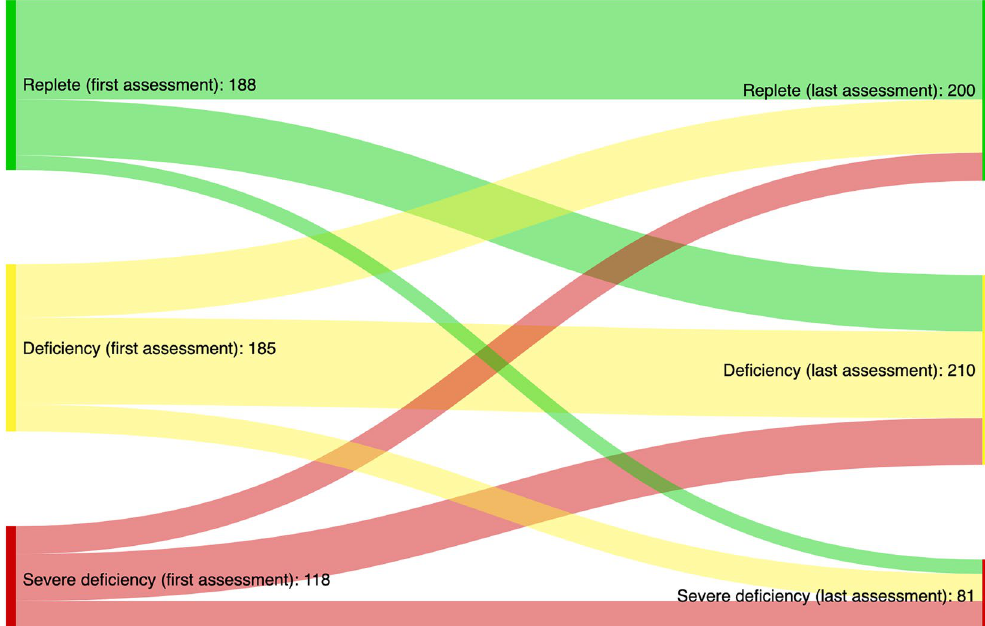
Figure 1. The figure displays changes in vitamin D status categories from the first (left) to the last (right) assessment for participants with at least two vitamin D measurements ( n = 491). Definitions: vitamin D replete = serum 25(OH)D > 50 nmol/l, deficiency = serum 25(OH)D > 50 nmol/l severe deficiency = serum 25(OH)D < 25